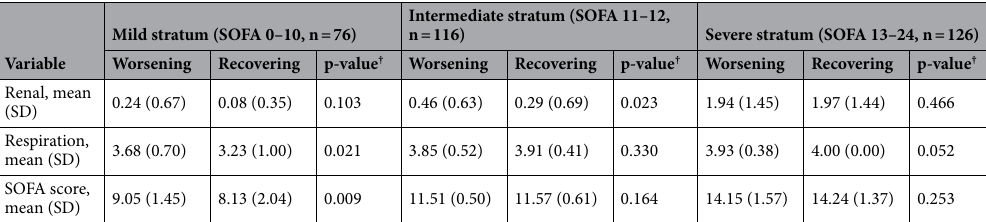
Table 2. Clinical characteristics of the trajectory subphenotypes in NYP-WCMC cohort. BMI Body mass index, HIV human immunodeficiency virus, NYP-WCMC New York Presbyterian Hospital-Weill Cornell Medical Center, SD standard deviation, SOFA Sequential Organ Failure Assessment. † p-value calculated by Chi-square test/Fisher’s exact test, or student’s t-test/Mann–Whitney test where appropriate. ** False discovery rate corrected p-value < 0.05.